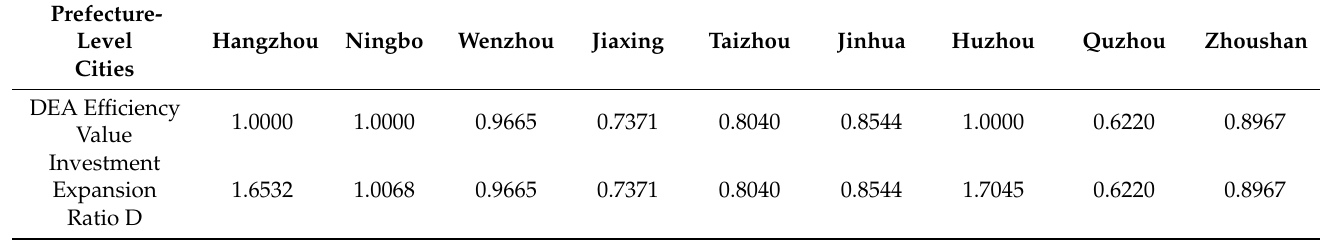
Table 4. The DEA efficiency value and investment expansion ratio value D of nine prefecture- level